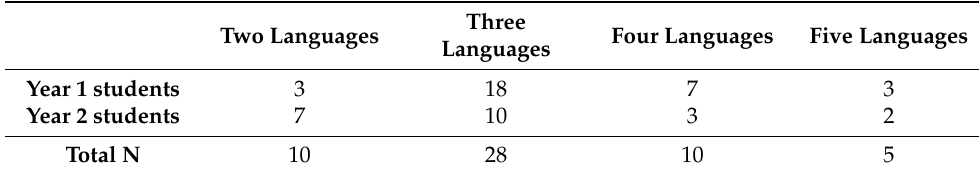
Table 2. Self-reported language competence: number of languages in which participants can carry out a conversation.